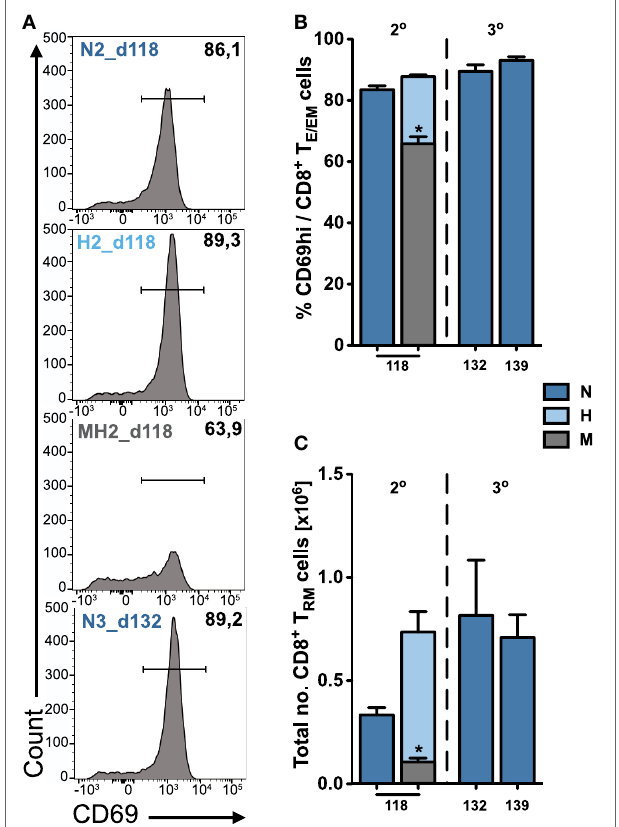
FigUre 5 | Quantification of tissue-resident CD8 + T RM cells in the liver. (a) Representative FACS histograms showing the expression of CD69 on hepatic T E/EM cells for long-term responses of vaccinated animals. Percentage (B) and total number (c) of tissue-resident CD8 + T RM cells among T E/EM cells indicating increasing numbers according to the dose and number of injections. Numbers below the plots indicate time of measurement in days post prime. Numbers of animals per group are specified within Table S1 in Supplementary Material. Graph bars depict means with SEM; * p < 0.05; ** p < 0.01; *** p < 0.001; multiple nonparametric rank-based relative